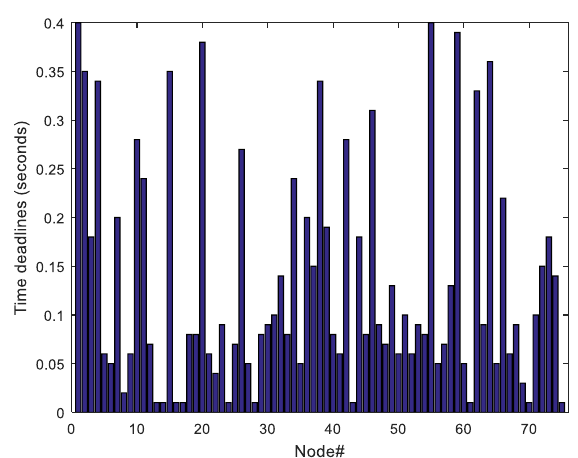
Figure 4. Time Deadlines of the Nodes affiliated with a cluster-head